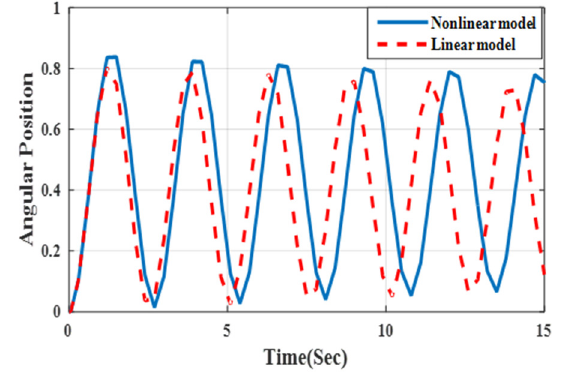
Fig. 2. Time response for linear and nonlinear model.